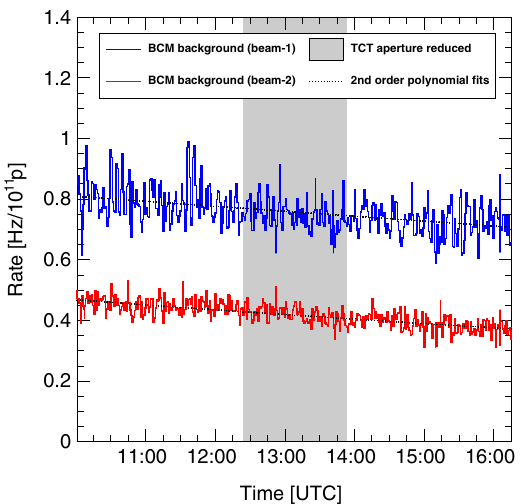
FIG. 7. B1 and B2 background rates measured by the ATLAS BCM before, during and after the period when the vertical TCTs were tightened by about 0 . 6 σ . The polynomial fits take into account only the periods before and after the period of reduced aperture. The data are taken from Ref. [24]. The larger fluctua- tions of the B1 background are due to small oscillations of the beam screen [50] temperature on the side of the incoming